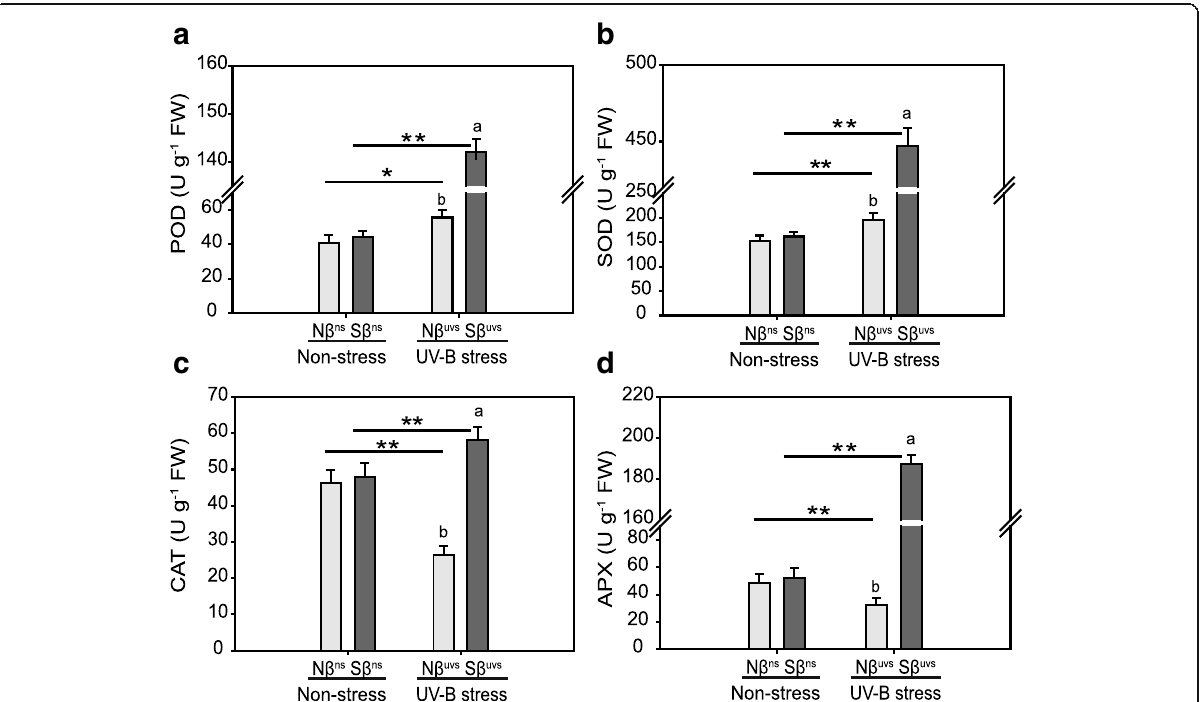
Fig. 5 Activities of ROS scavenging enzymes in N β and S β plants under non-stress and UV-B stress conditions. We measured the activities of antioxidant enzymes, A peroxidase (POD), B superoxide dismutase (SOD), C catalase (CAT), and D ascorbate peroxidase (APX), in seedlings of N β and S β plants. The means with different letters are significantly different (P < 0.05) within the same treatment. Lines with asterisks indicate significant differences between non-stress and UV-B stress conditions of the same plants (N β ns vs. N β uvs and S β ns vs. S β uvs ), as determined by Student ’ s t test (* P < 0.05, ** P <